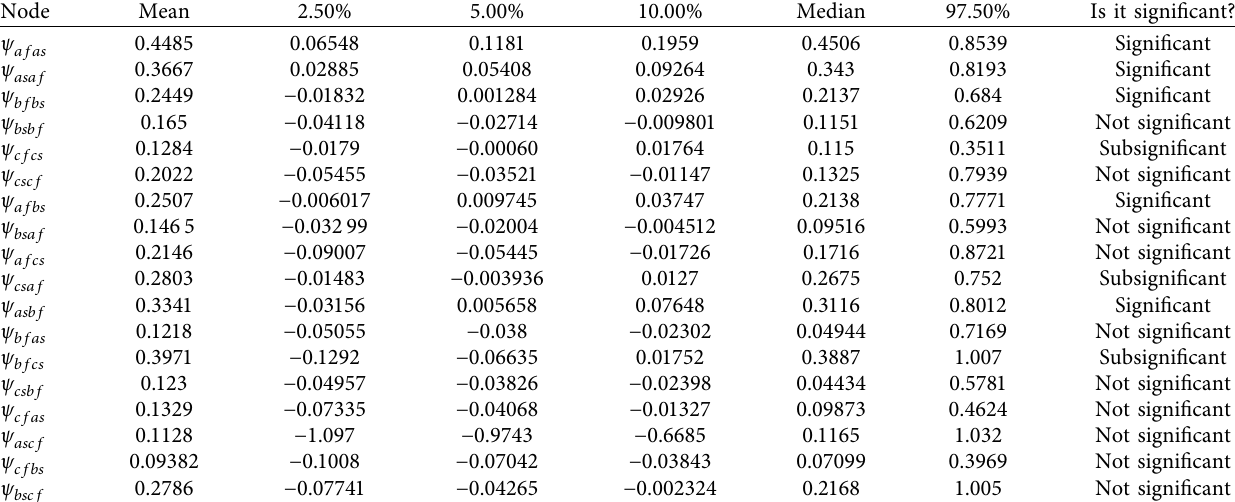
Table 5: Volatility spillover parameter estimation result between oil future and spot